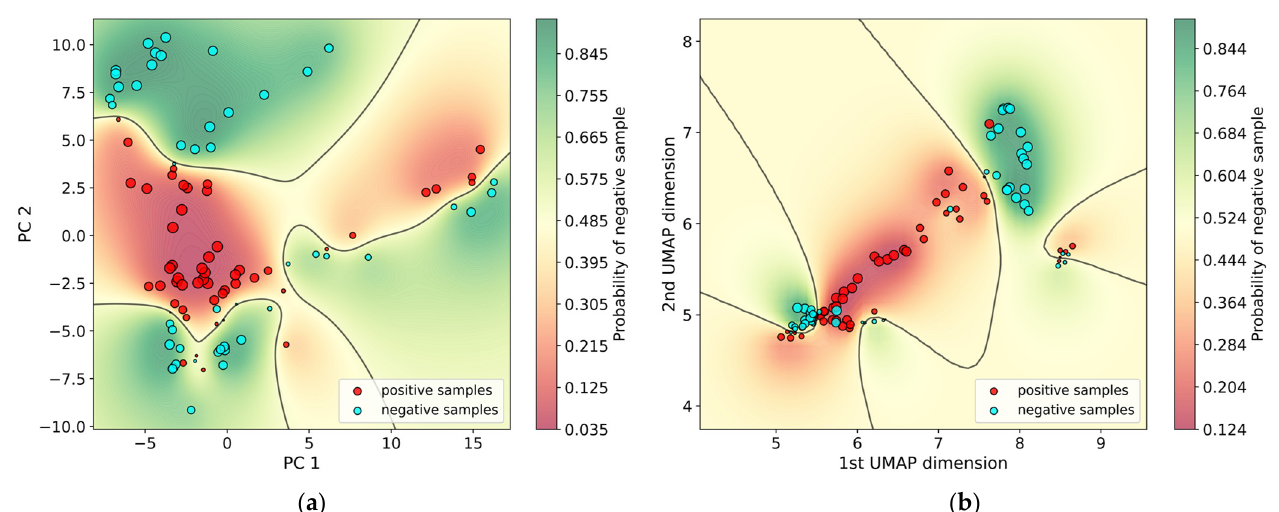
Figure 7. ( a ) GPC model decision boundary plot with uncertainty estimation for PCA ( b ) GPC model decision boundary plot with uncertainty estimation for UMAP.